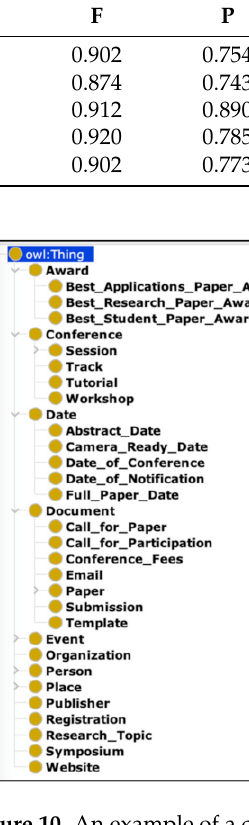
Figure 10. An example of a conference ontology learned by